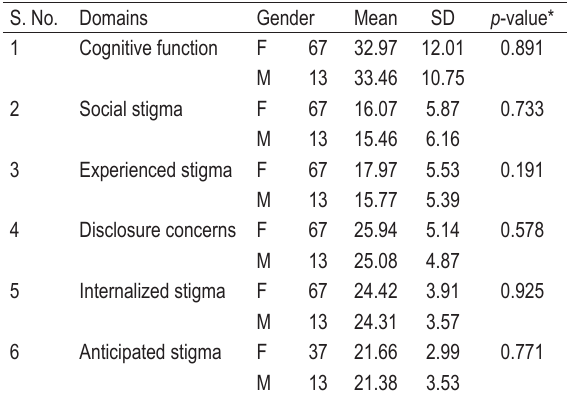
TABLE 5. Comparison of stigma mean scores between the gender and six domains S. No.